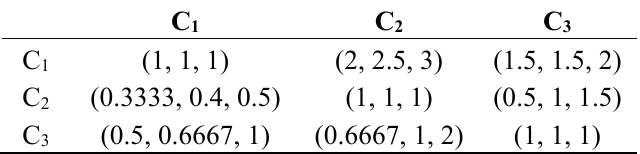
Table 6. The comparison matrix of the construct for Expert